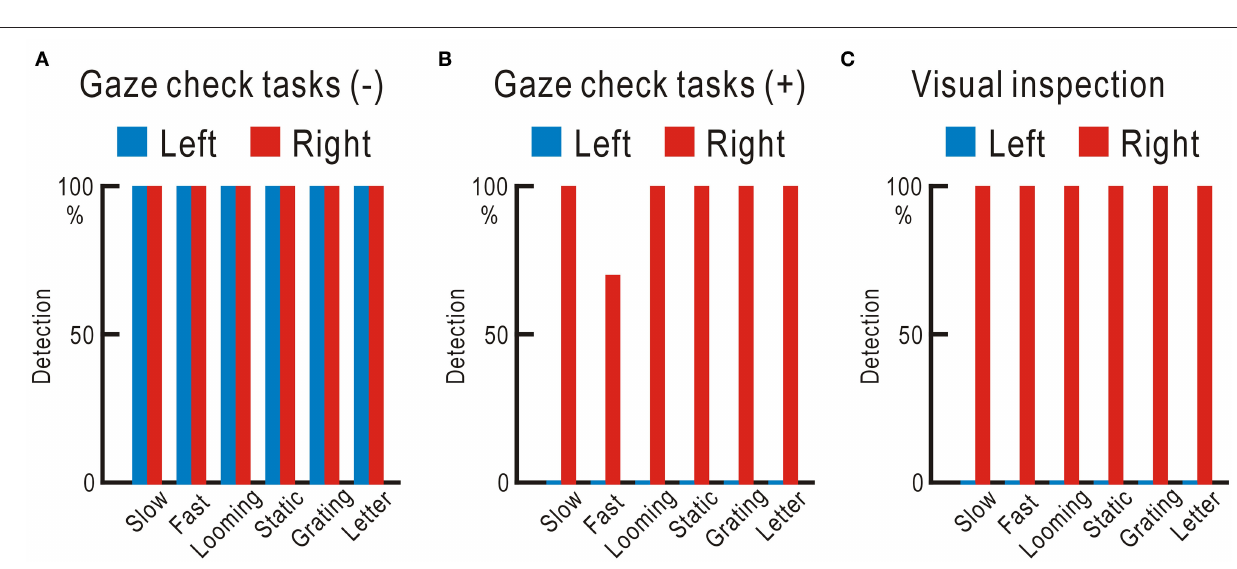
FIGURE 6 | (A) Visual field test without gaze check tasks. Visual stimuli completely detected in both the left and right visual fields. (B) Visual field test with gaze check tasks. No visual stimulus detected in the left visual field. (C) Visual field test with visual inspection of the gaze. No visual stimulus detected in the left visual